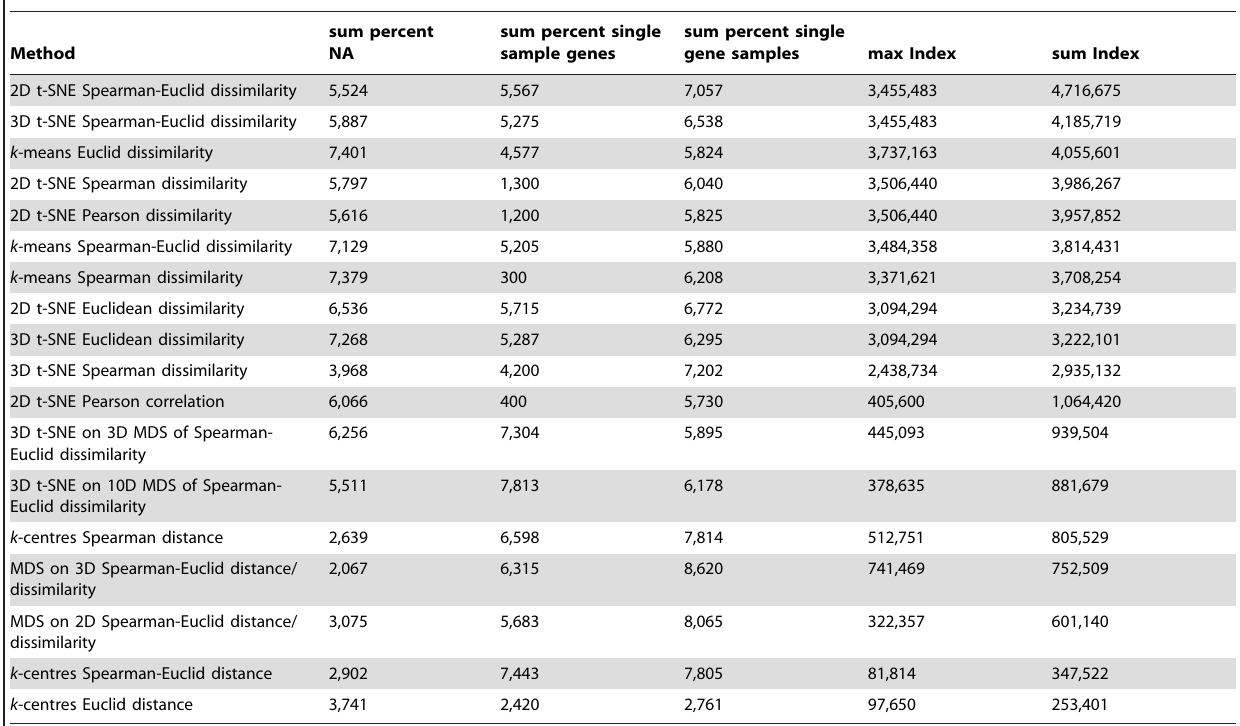
Table 1. Evaluation of clustering